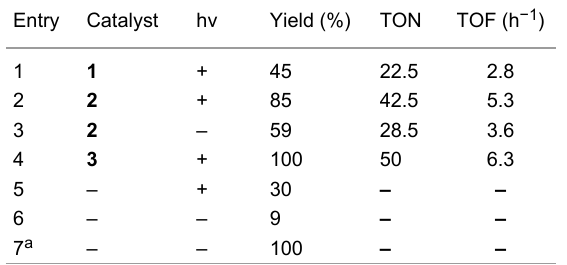
Table 3: Results of photoinduced Diels–Alder-reaction.